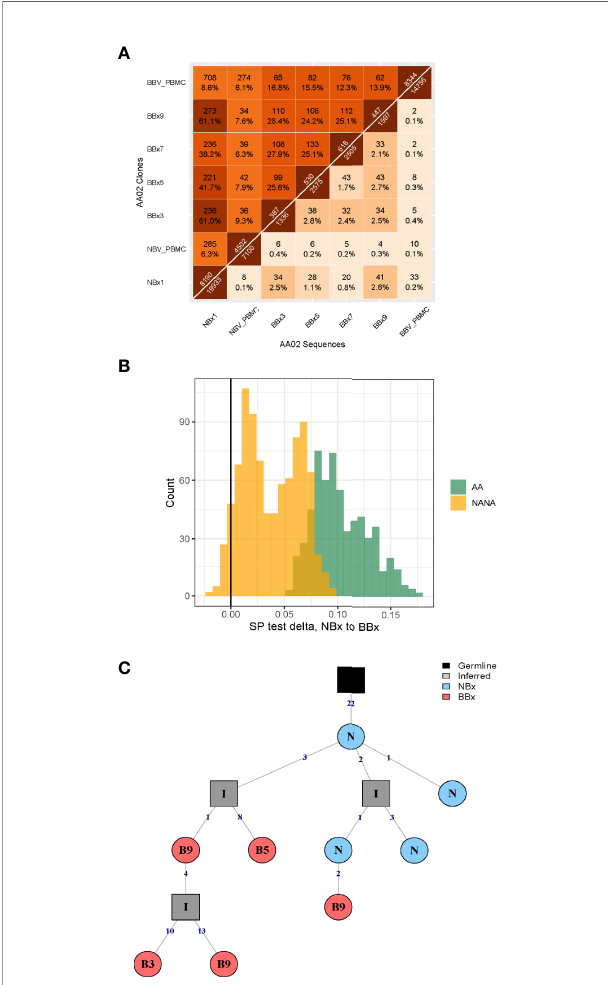
FIGURE 5 | High frequency of immunoglobulin gene clones spanning nasal and bronchial mucosa and evidence of enrichment of traf fi cking from the nose to the lungs. (A) Overlap heatmap showing the numbers and frequencies of sequences (below the diagonal) and clones (above the diagonal) shared between all pairs of samples from subject AA02. Numbers immediately above and below the diagonal indicate the number of sequences and clones in each sample, respectively. There is a high degree of overlap of clones in the nasal biopsy (NBx1) and all the bronchial biopsies (BBx) (38-61% at clonal level) and between individual bronchial biopsies (24-28% at clonal level). Some overlap of clones is also seen in the two blood samples taken at the same times as the nasal and bronchial biopsies (6% at clonal level) as well as between both samples and the nasal biopsy (6% and 9%, respectively) and bronchial biopsy samples (6-9% for the NBV_PBMC taken at the time of the nasal biopsy and 12-19% for BBV_PBMC taken at the time of the bronchoscopy). A lower degree of overlap is found at sequence level, as this requires 100% nucleotide sequence identity. (B) Lineage tree analysis by maximum parsimony phylogeography showing an enrichment of switches along B cell lineage trees from nasal to bronchial mucosa compared to randomized trees. The enrichment is signi fi cantly more pronounced in the atopic asthmatics (AA, green, p<0.02 for all subjects) compared to the non-atopic controls (NANA, yellow, p<0.05 in 4 of 9 subjects). (C) Example of a phylogenetic tree from subject AA06 showing a clear pattern of traf fi cking from the nose (N, blue) to the lungs (bronchial biopsies B3, B5 and B9, red). N is an abbreviation for nasal biopsy (NBx) and B3, B5 and B9 abbreviations of bronchial biopsies BBx3, BBx5 and BBx9. All the members of this particular clone are of the IgA